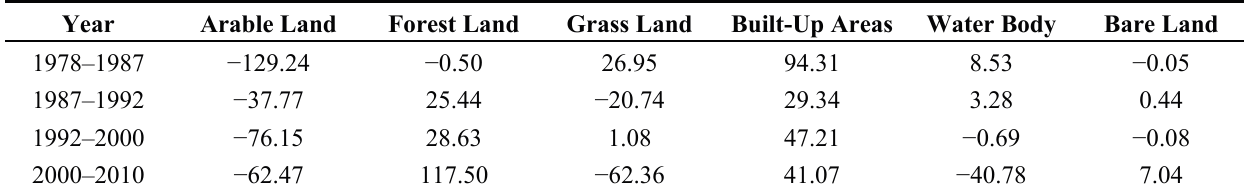
Table 5. The land use and land cover change rate during four periods (km 2